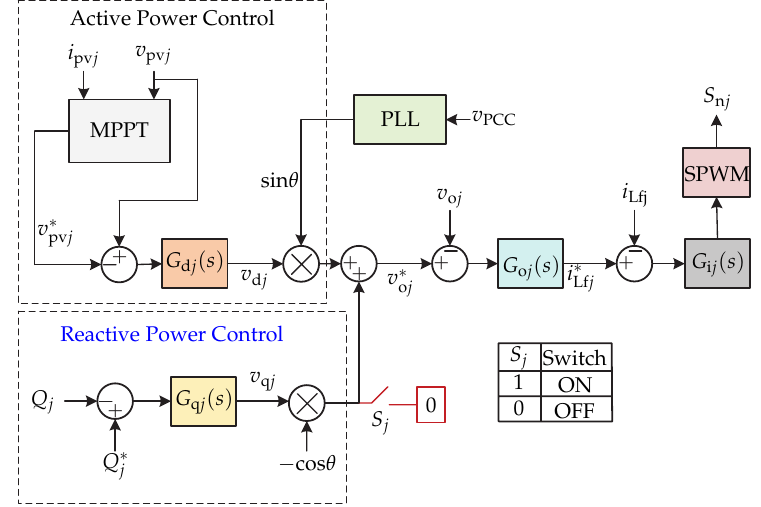
Figure 29. Control strategy proposed in [ 65].